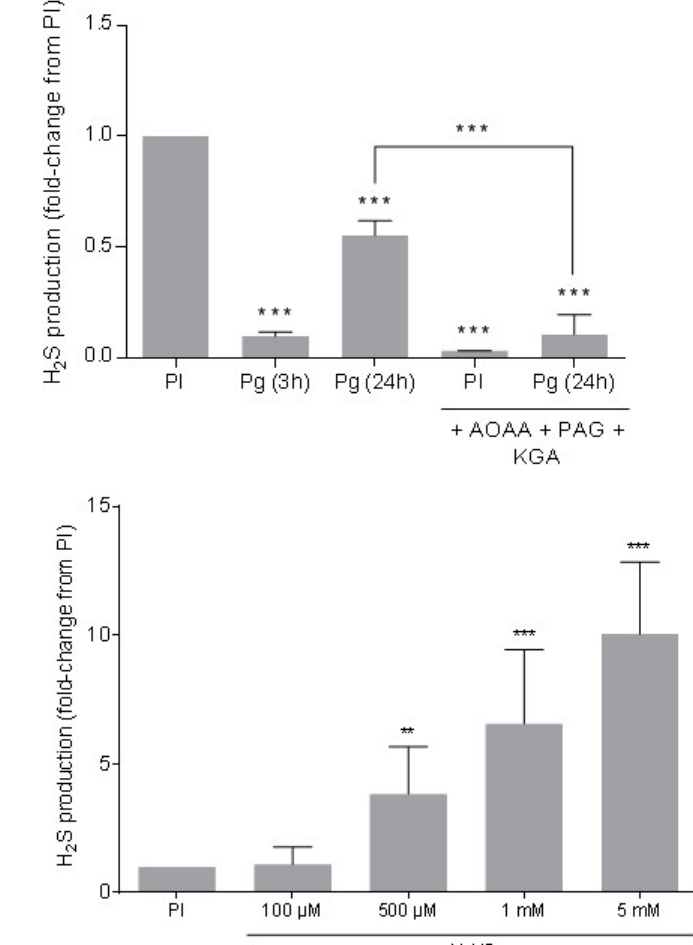
Figure 3. H 2 S production in Xenopus oocytes. ( A ) Endogenous H 2 S measurement was performed in prophase 1 blocked oocytes (PI) and oocytes 3 or 24 h after progesterone (4 μ g/mL) (Pg 3 h or 24 h)